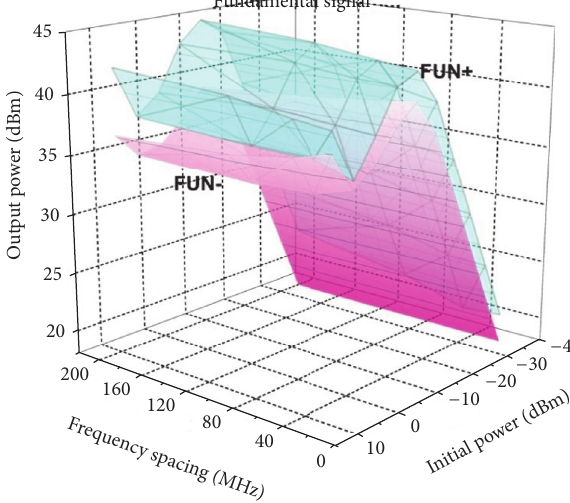
Figure 2: The 3D AM/AM curves of FUN − and FUN+ according to the increasing fundamental frequency